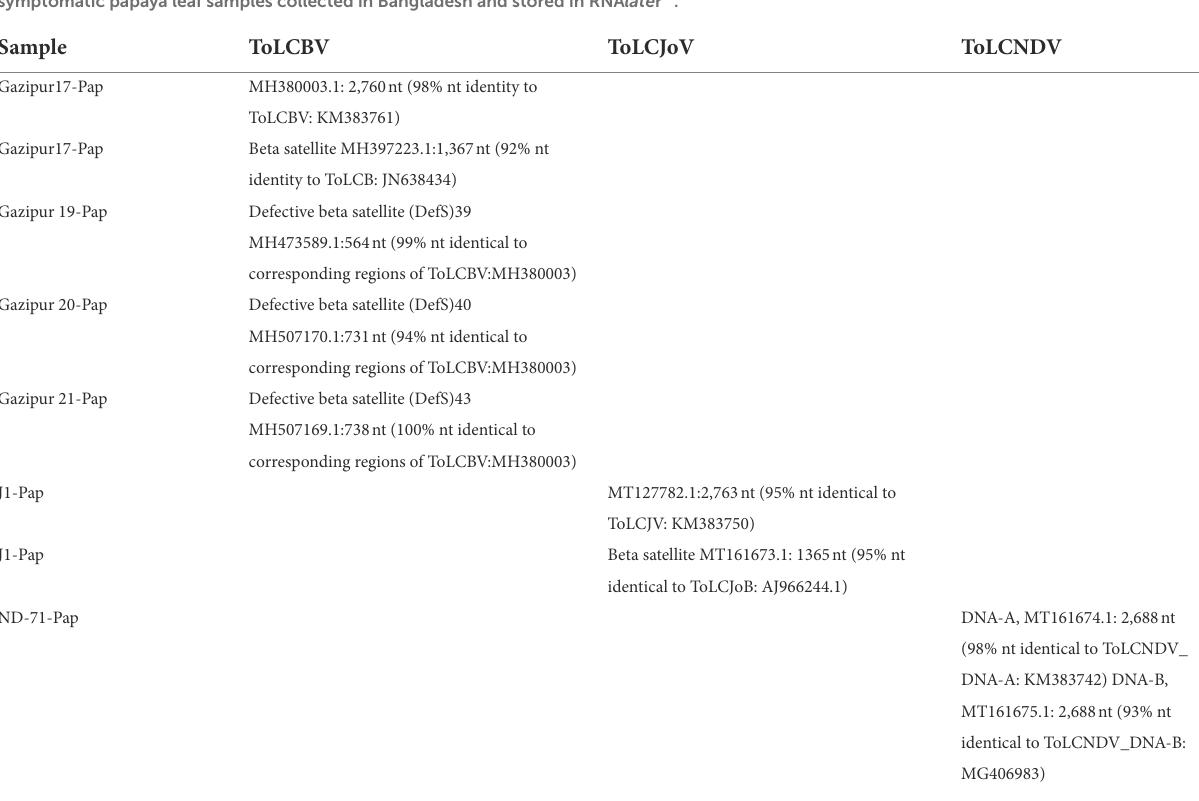
TABLE 5 GenBank accessions of Sanger sequence-derived nucleotide (nt) sequences representing begomovirus genome sequences from symptomatic papaya leaf samples collected in Bangladesh and stored in RNA late r ®